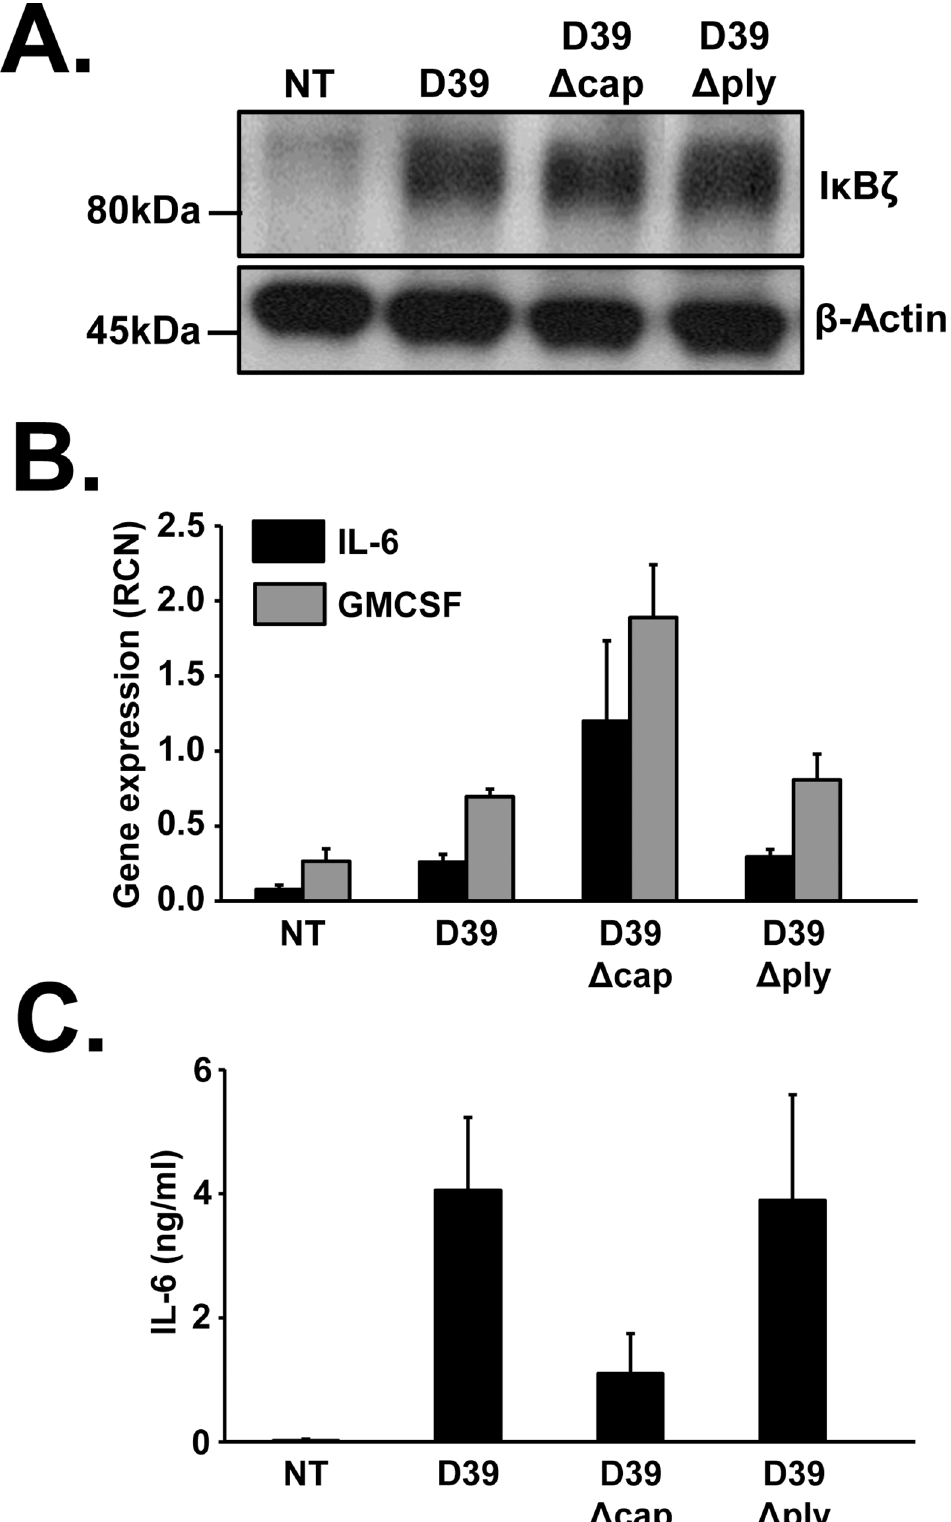
Fig 4. Capsule and pneumolysin of D39 are dispensable for I κ B ζ induction. Human monocytes (10 6 cells/ml) were infected with D39, D39 Δ cap or D39 Δ ply at an MOI of 0.1 for 3 and 6 h. Cell extracts were